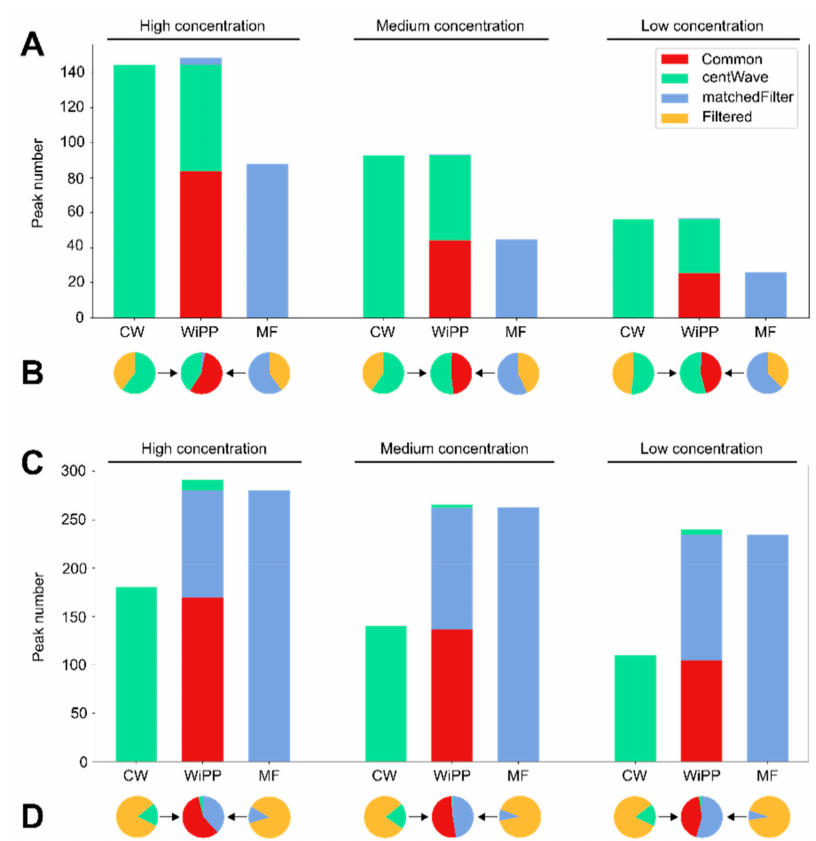
Figure 1. Number of peaks detected by individual algorithms on the high, medium, and low concentrations of the standard mix dataset 1 in low resolution ( A , B ) and high resolution ( C , D ). ( A , C ): Number of unique high-quality peaks as classified by workflow for improved peak picking (WiPP)andtheiralgorithmoforigin. ( B , D ):ProportionofpeaksdetectedbycentWaveandmatchedFilter, rejected by at least one of the quality filters in